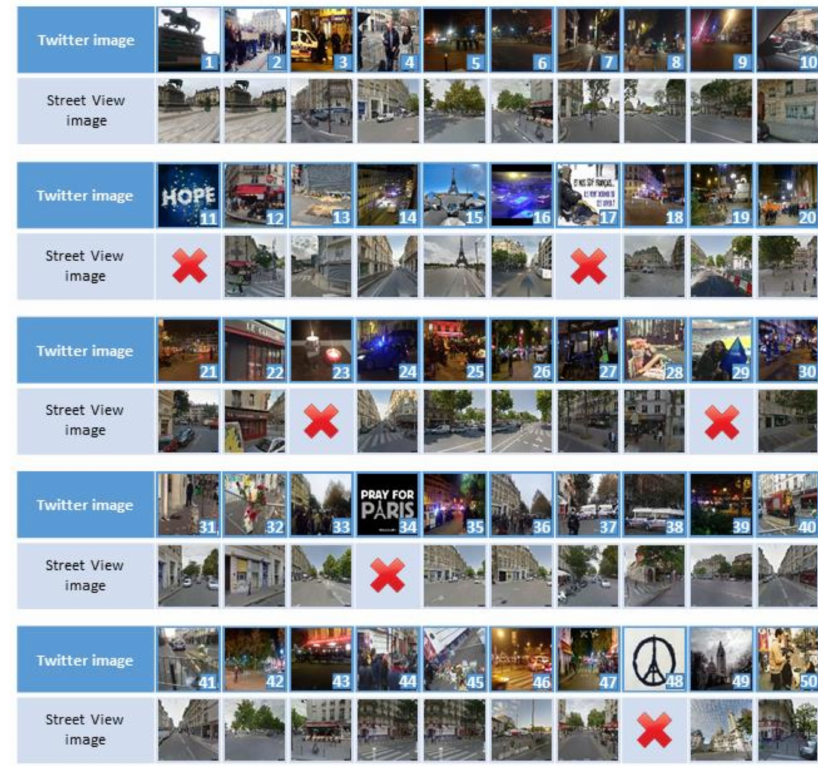
Figure 13. Some examples of images retrieved on Twitter during terrorist attacks occurring in Paris (2015) and the corresponding images retrieved from Google Street View. The red X indicates that the ASMIS system was unable to find a correct